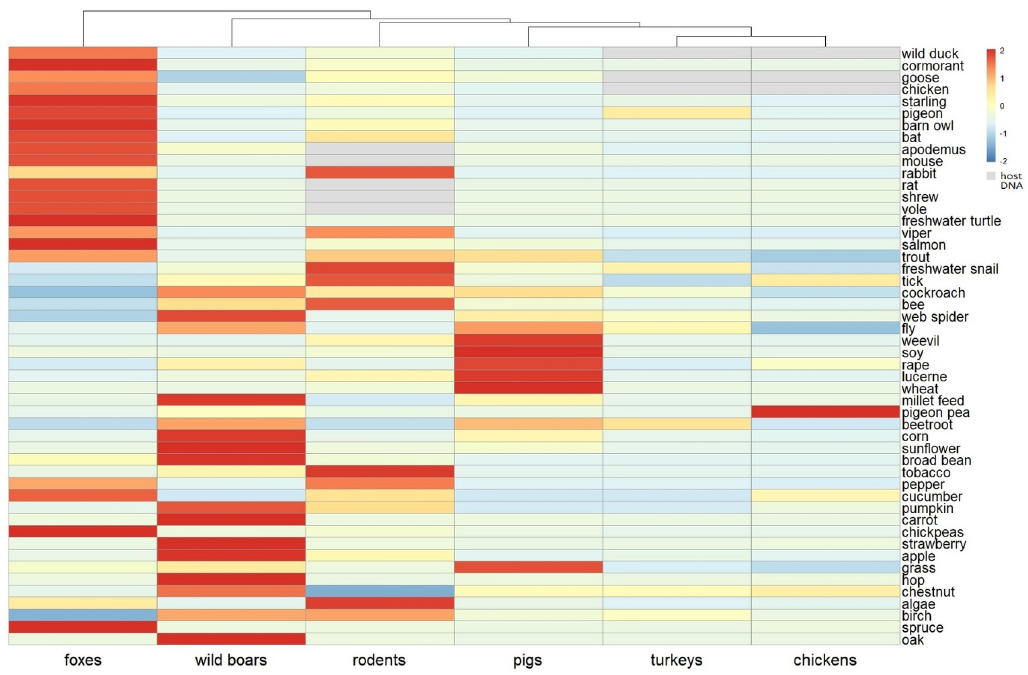
Fig 8. Diet of tested animals. Heat map based on relative abundances (in RPM: reads per million) of selected plants, vertebrates and invertebrates with Z-score scaling. Samples with high relative abundances get positive values (red color) and those with relatively low get negative values (blue colors). Grey color corresponds to host DNA. Complete-linkage clustering of Euclidian distances was applied for clustering the samples.